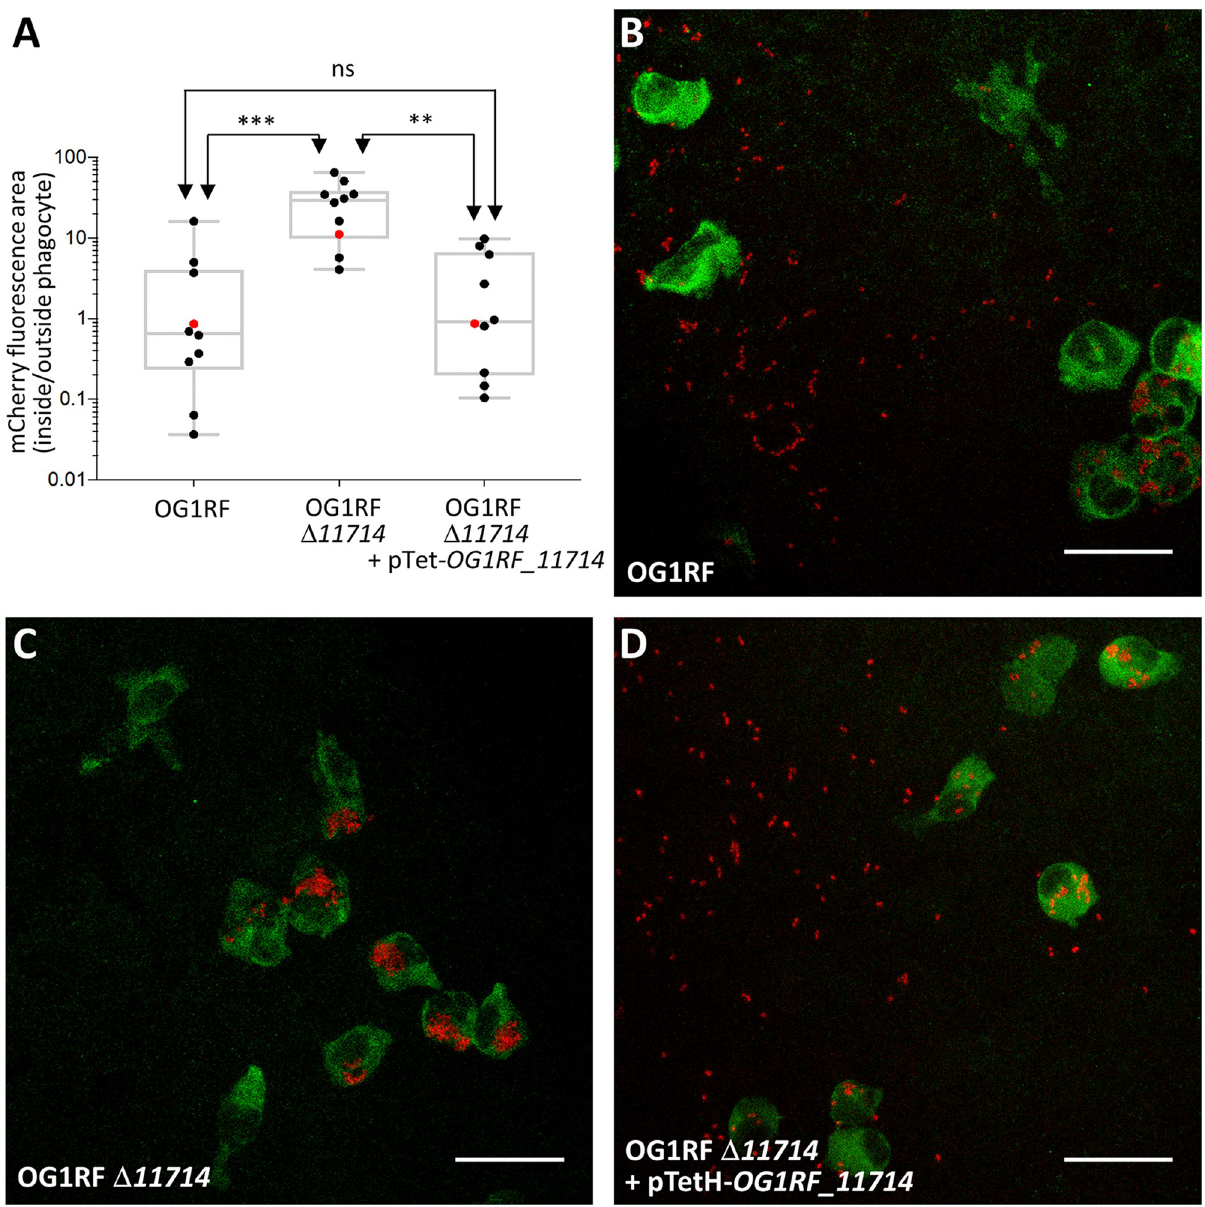
Fig 8. epaX mutant cells are more prone to phagocytosis than wild-type and complemented cells. A . Quantification of E . faecalis uptake by zebrafish phagocytes. Embryos were infected with 1,600 CFUs of E . faecalis cells constitutively producing mCherry and fixed in 4% paraformaldehyde 1.5 h post infection. Phagocytes were immunolabelled using rabbit anti L-plastin antibodies and detected with goat anti-rabbit antibodies conjugated to Alexafluor 488. The infected and immunolabelled embryos were imaged using a scanning confocal microscope. The ratio of mCherry fluorescence signal area associated with phagocytosed and free bacteria was measured using the Fish Analysis Fiji plugin. The uptake of mutant OG1RF Δ 11714 ( Δ epaX ) was significantly higher when compared to the wild-type (OG1RF; ��� P = 0.0006) and complemented strain (OG1RF Δ 11714 + pTetH- OG1RF_11714 ; �� P = 0.0049). No difference in phagocytosis was observed between the wild-type and complemented strains (ns, P > 0.05). Representative images showing E . faecalis uptake in zebrafish embryos are shown. Each picture corresponds to the quantification result indicated with a red dot in A , following infection with OG1RF ( B ), OG1RF Δ 11714 ( Δ epaX ) ( C ) and the complemented strain ( D ). Phagocytes labeled with L-plastin appear in green, mCherry labelled bacteria in red. Scale bar is 25 μ m.